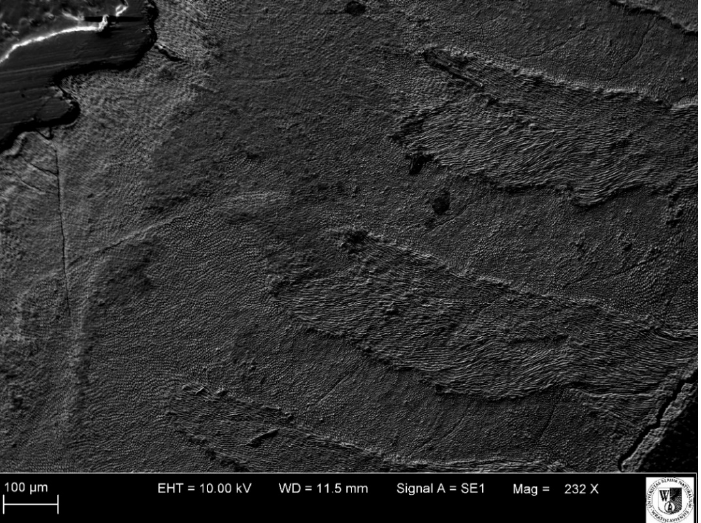
Figure 10. SEM micrograph of enamel (horizontal section through the crown) on the third premolar (P 3 ) of the white rhinoceros female. EHT: Electron high tension voltage; WD: Working distance between the sample surface and the low portion of the lens; Signal A = SE1: Secondary electrons emitted from the top of the sample surface resulting from interaction with primary